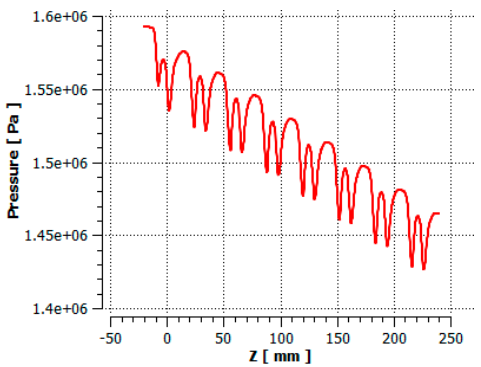
Figure 9. Static pressure in the first 8 − stage blades’ channel.